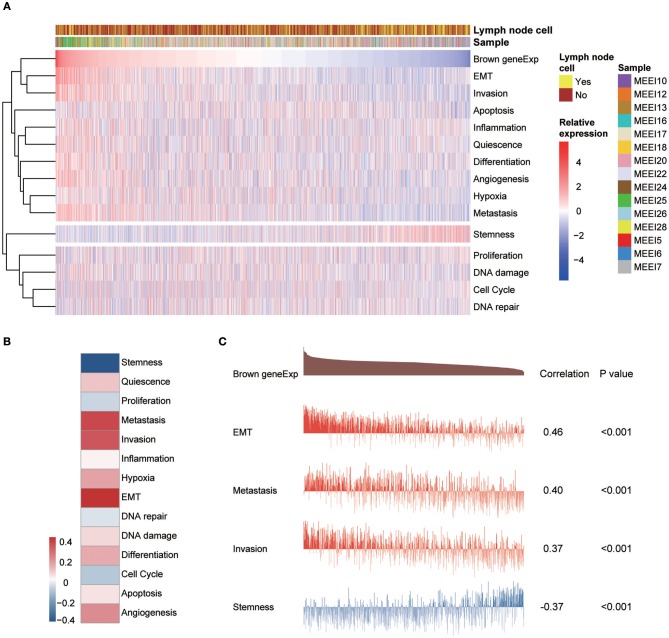
(A) Heatmap showing the correlations between the expression of key module genes and functional state signatures from an analysis of 2,105 single cancer cells in the GSE103322 dataset. MEE5, MEE6, MEE7, MEE10, MEE12, MEE13, MEE16, MEE17, MEE18, MEE20, MEE22, MEE24, MEE25, MEE26, and MEE28 represent cells from different patients. The sources of the cells (primary lesion or metastatic lymph node) are noted. (B) Heatmap of the correlations between gene expression and 14 functional states. (C) Details of the relationships between brown module gene expression and “EMT,” “metastasis,” “invasion,” and “stemness”.